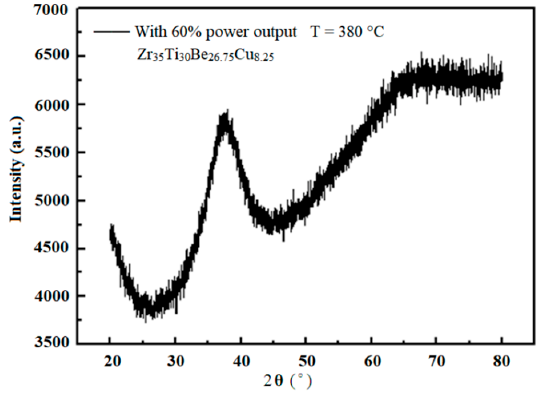
Figure 8. XRD results of ultrasonic uniaxial compressed Zr35 sample.